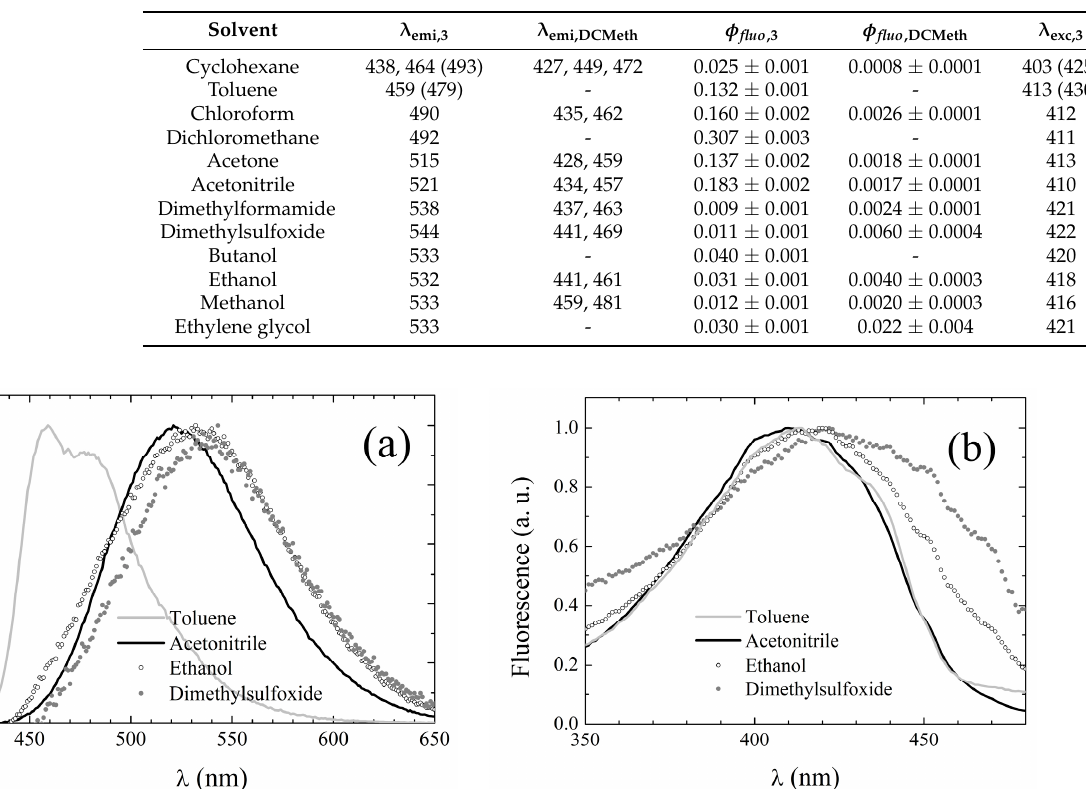
Table 7. Emission peak wavelength, λ emi, 3 , and the fluorescence quantum yield, φ fluo , 3 , of the different solvents of Table 1 are compared to those of DCMeth, λ emi,DCMeth and φ fluo ,DCMeth , reproduced from [39] for the sake of straightforward comparison. The peak excitation wavelength of 3 , λ exc, 3 , is also reported.